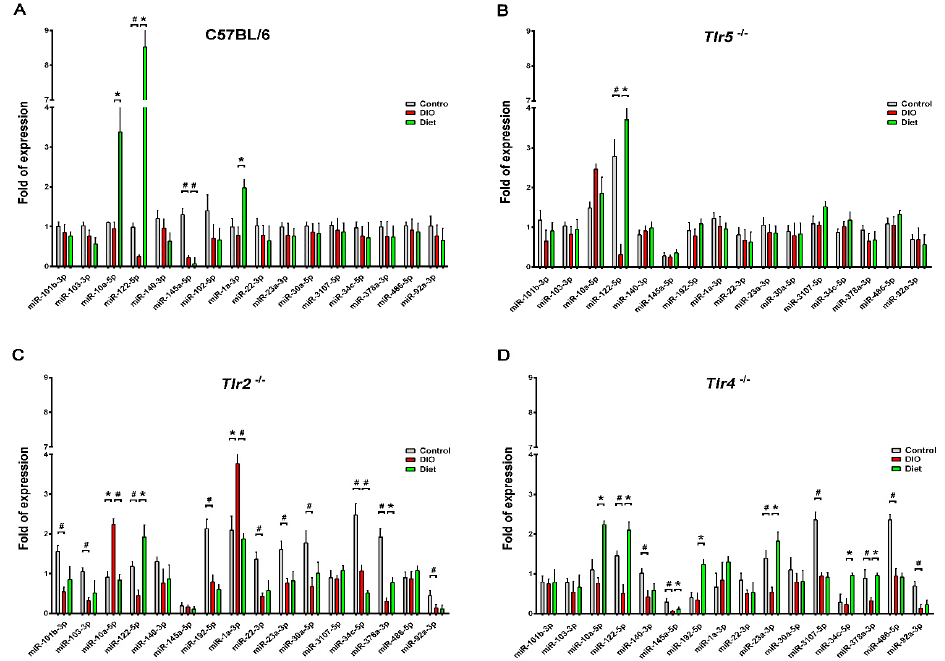
Figure 4. Expression of dysregulated miRNAs in real-time quantitative reverse transcription polymerase chain reaction (RT–qPCR) in the DIO group of C57BL/6 ( A ), Tlr5 − / − ( B ), Tlr2 − / − ( C ), and Tlr4 − / − ( D ) mice after weight reduction. * increase expression with p < 0.05 # decrease expression with p < 0.05.